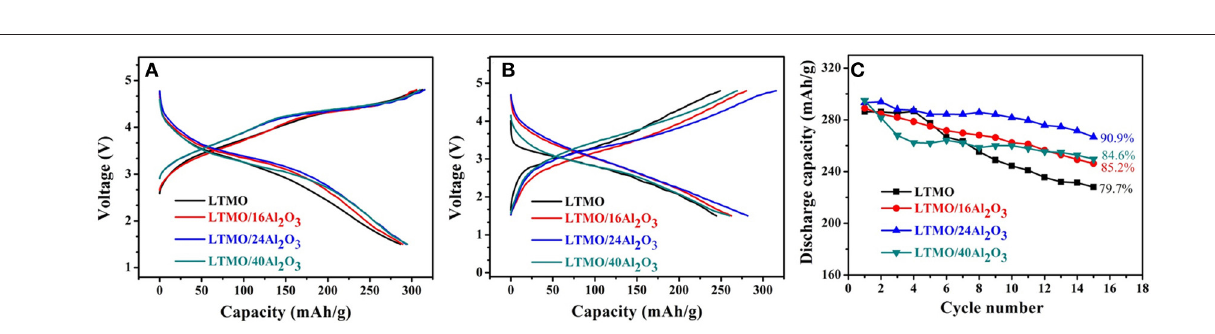
scanning rate of 0.5 mV s − 1 . For the LTMO electrode (shown in the Figure 6A ), the anodic peaks located at about 3.95